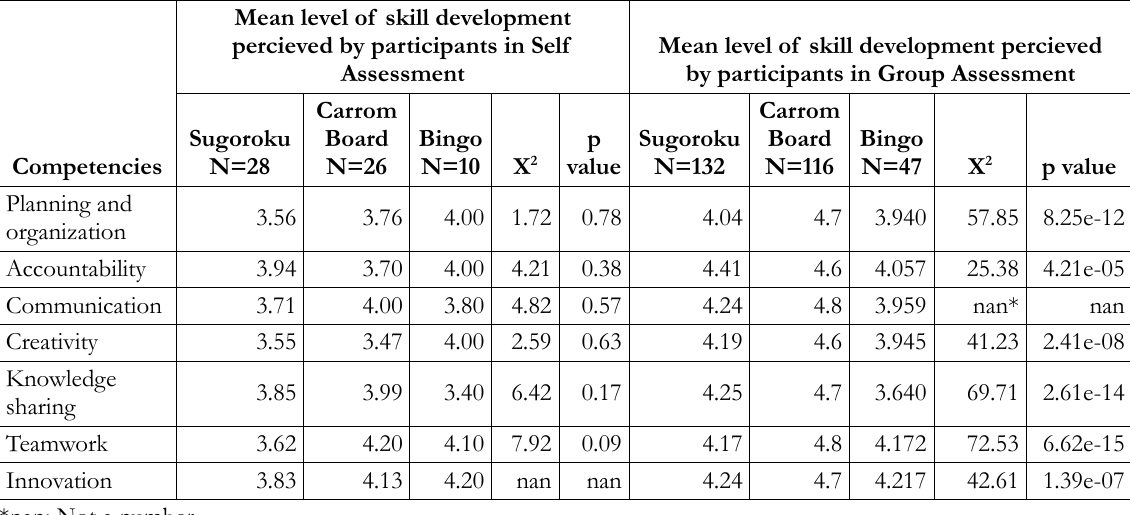
Table 2. Assessment of competencies by type of games administered